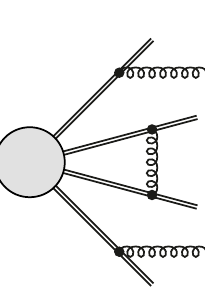
Figure 2 . Double soft-gluon emission dia- gram involving three Wilson lines. The con- tribution is a product of tree-level and one- loop single soft-gluon